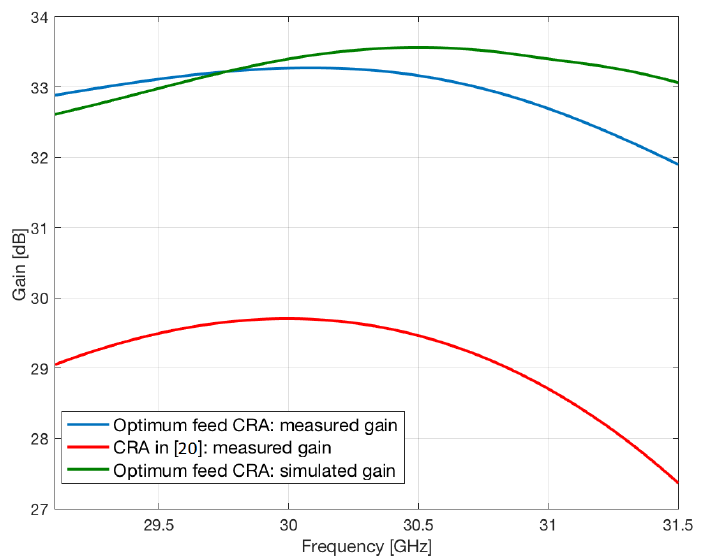
Figure 11. Variation of the gain vs. frequency of the CRA with the standard rectangular horn [20] and the optimal feed horn. For this last configuration, also the simulated values are